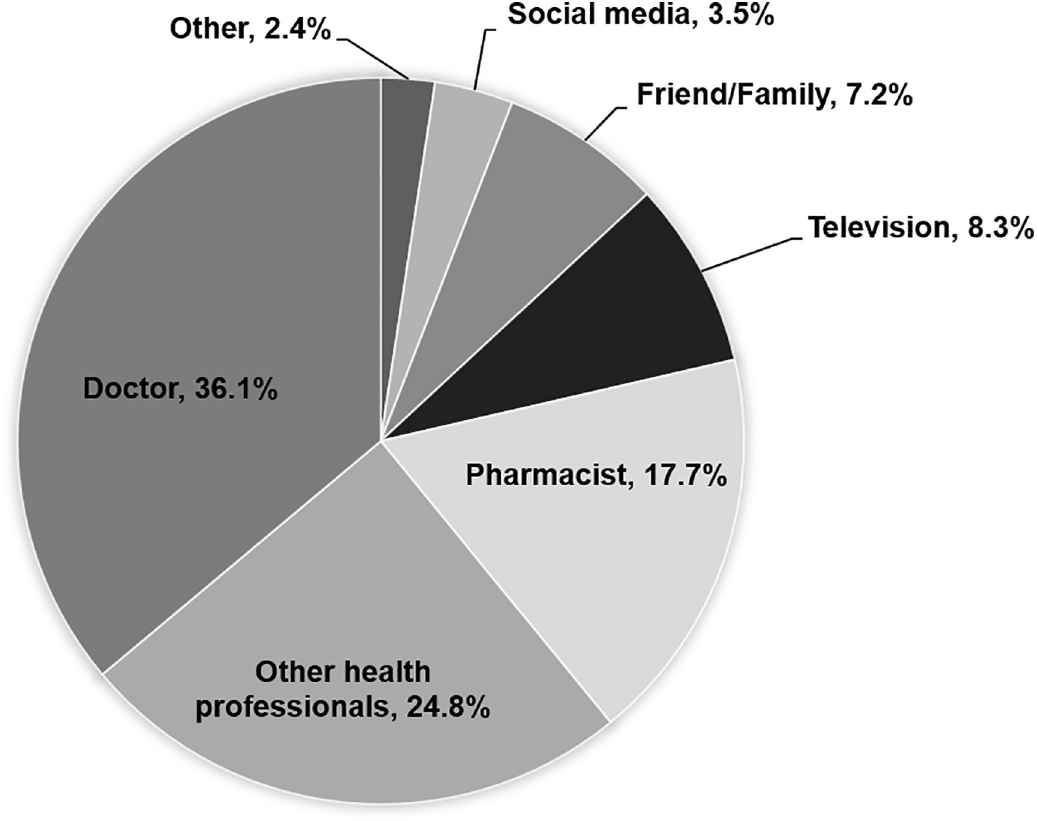
Fig 4. Source of information on antibiotics and AMR in the last year. Note: Others include leaflets, posters, newspapers and radio broadcasting.